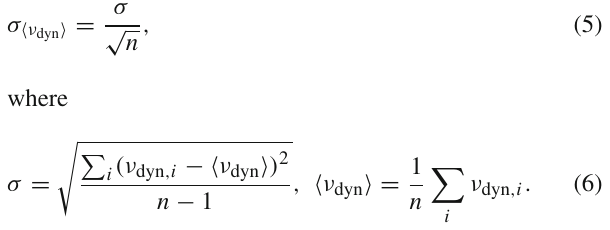
Fig. 2 Distributions of the TPC d E / d x signal of pions, kaons, elec- tronsandprotonsfittedwiththegeneralizedGaussianfunctioninagiven phase-space bin. The residuals are defined as the difference between data points and the total fit function normalized to the statistical error of the data points of pre-selected samples of pions, protons and electrons, iden- and Λ decays and photon tified by the reconstruction of K 0 S conversions, were fitted with a generalized Gaussian function of the